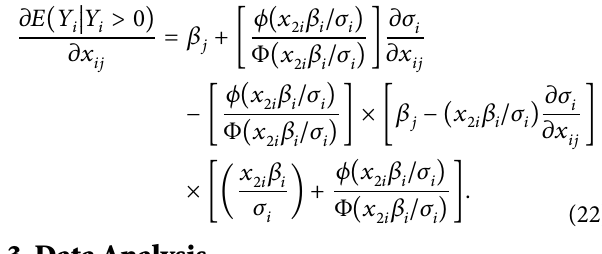
Figure 2: The process of a questionnaire